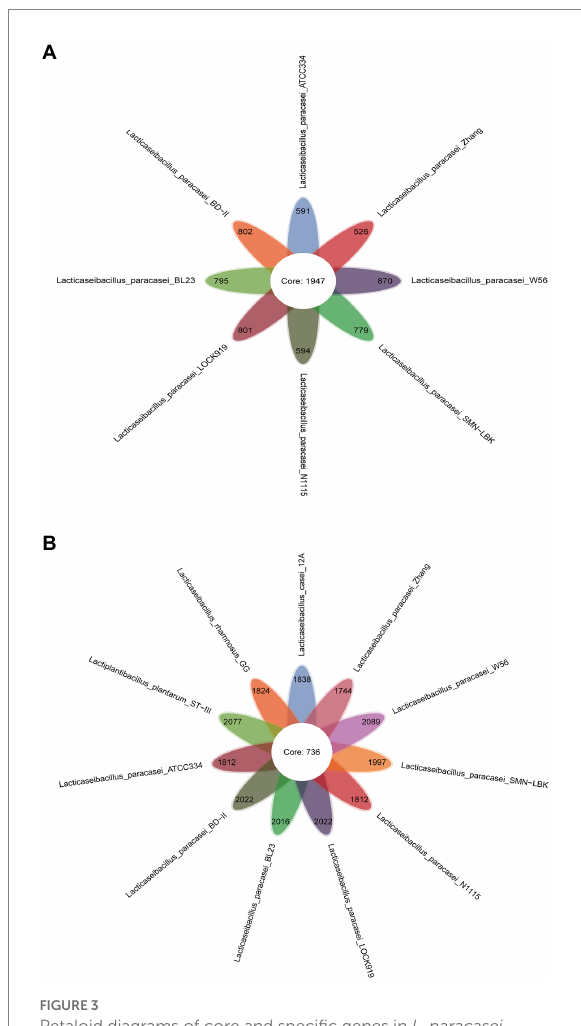
FIGURE 3 Petaloid diagrams of core and specific genes in L. paracasei strains (A) and all strains (B) . The numbers in the center of the petals represent the number of shared genes; the numbers at the top of the petals represent the number of unique